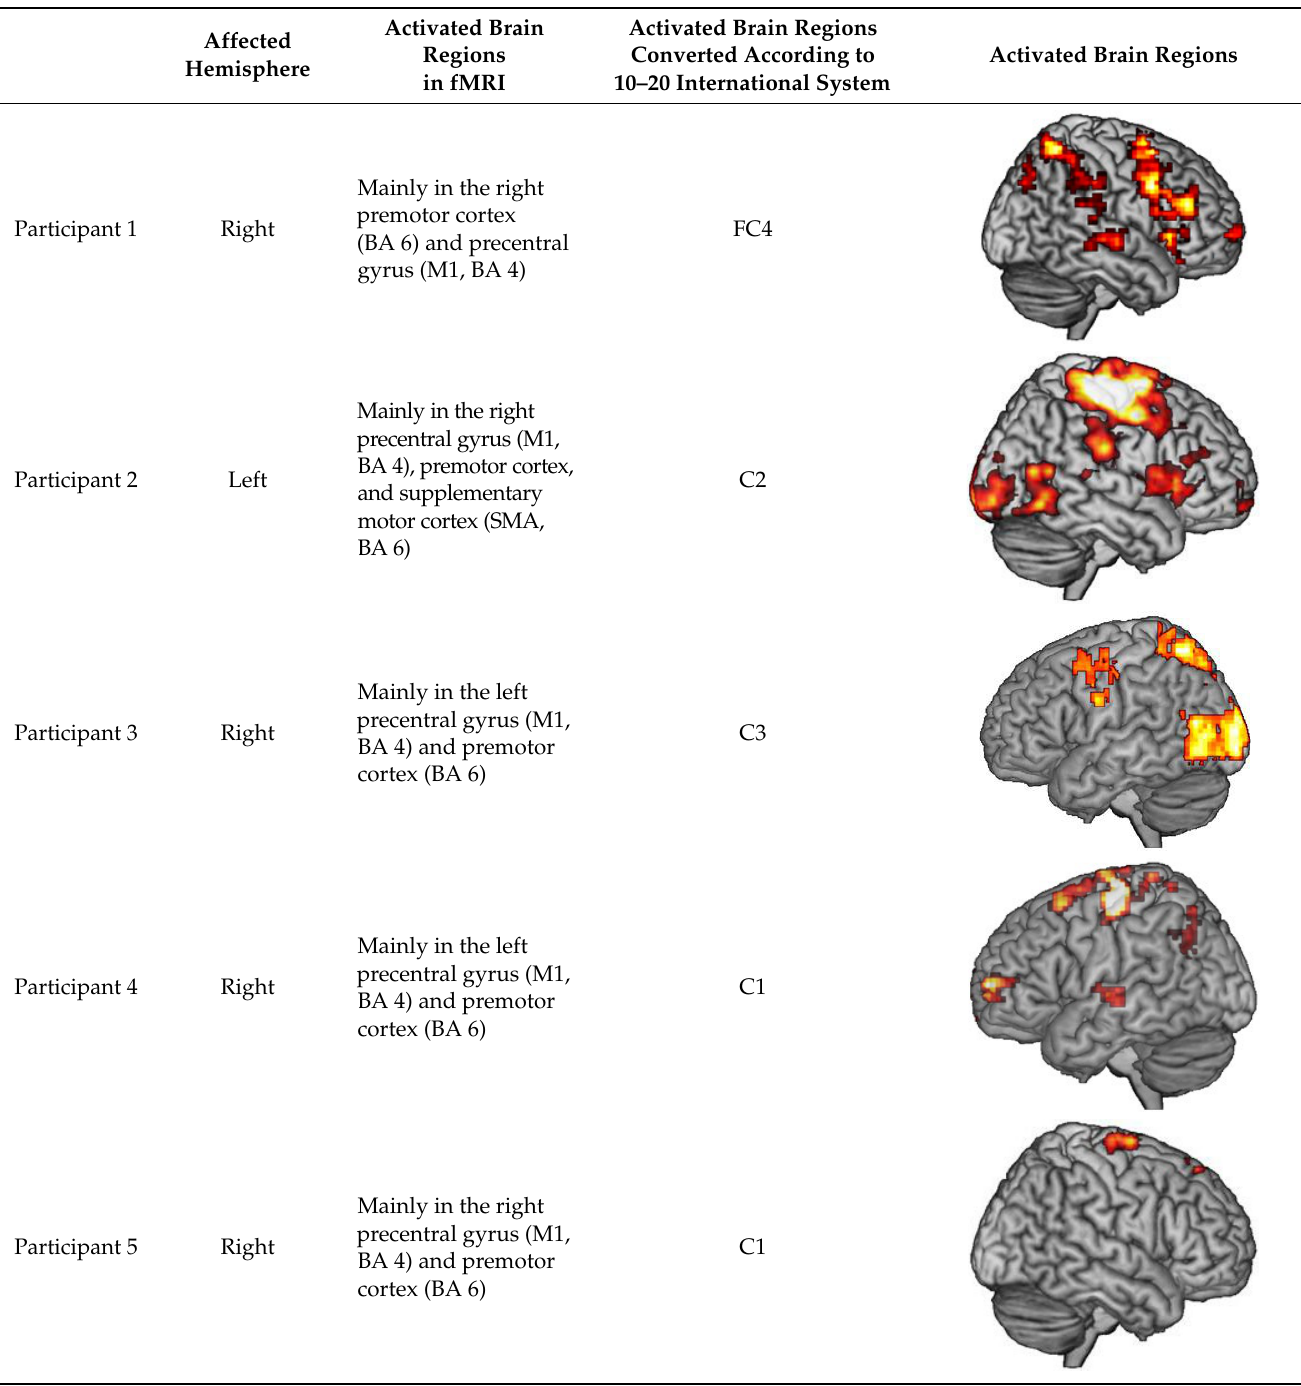
Table 2. Characteristics of each participant and the stimulating target of the experimental group.